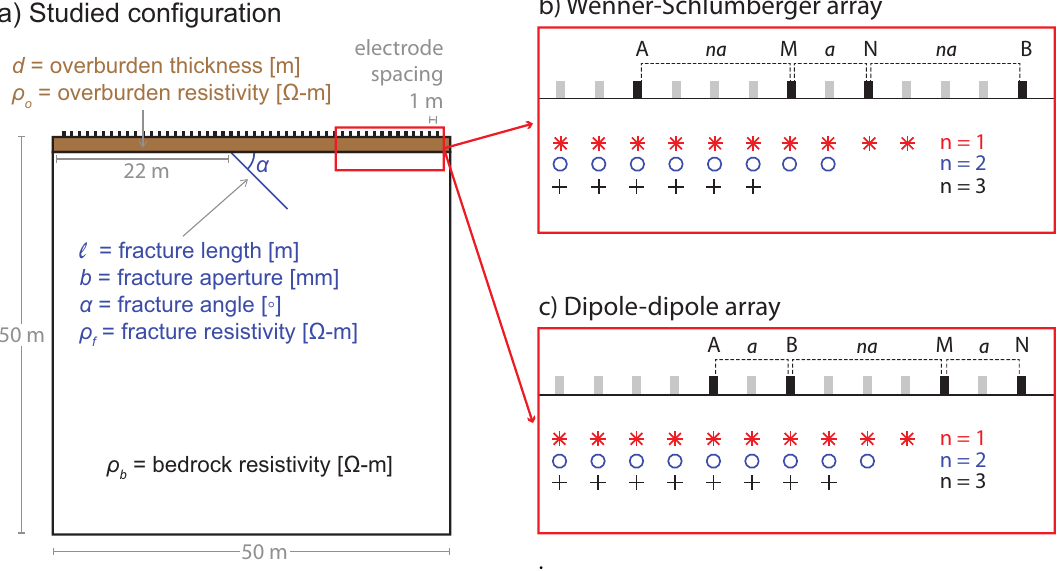
Figure 1. ( a ) Single-fracture configuration considered in our simulations with the fracture, bedrock, and overburden represented using blue, white, and brown, respectively. ( b ) Diagram showing the Wenner-Schlumberger and ( c ) dipole-dipole electrode arrays, where a is the minimum considered electrode spacing and n is the spacing factor ( n = 2 shown). A and B denote the current electrodes, whereas M and N denote the potential measurement electrodes. The symbols below the arrays indicate the center point of each measurement along with the relative depths of the three considered spacing-factor values, and correspond to the symbols used in Figures